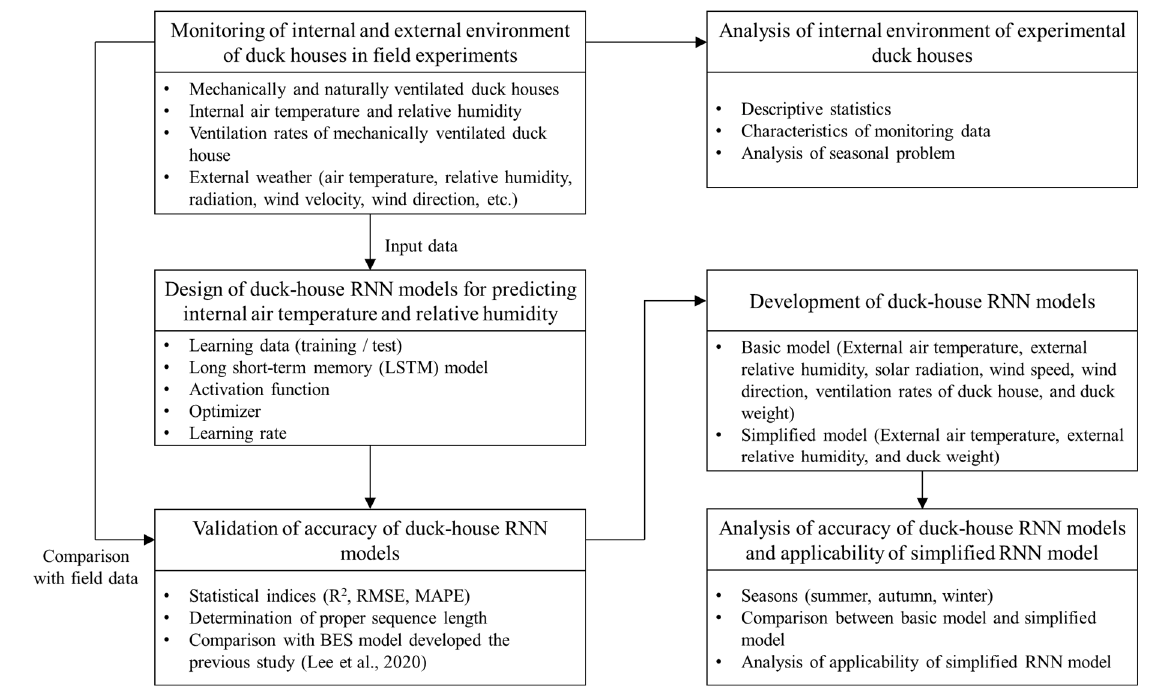
Figure 1. Flow chart of the experimental procedure of this study.